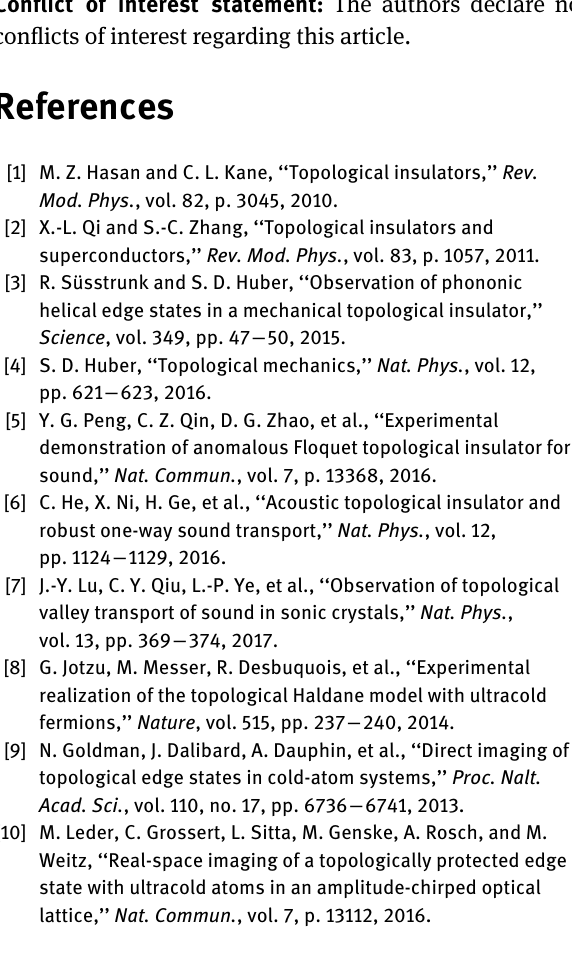
, and right, S out , arrays r l = d = 15 μ m, l r